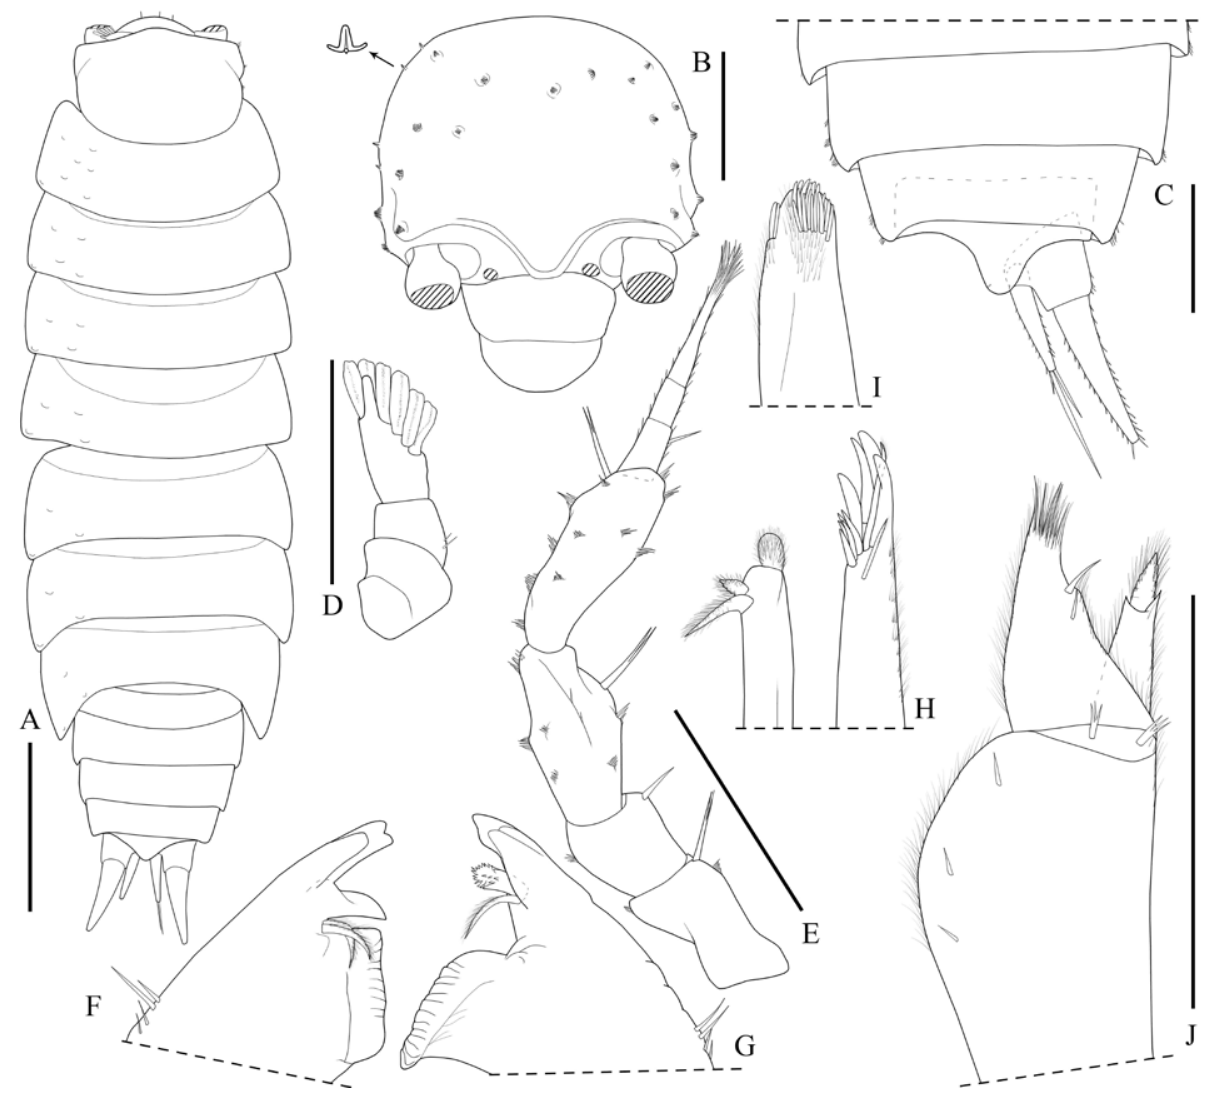
Figure 14. Pectenoniscus santanensis n. sp. Female paratype: A , habitus, dorsal view; B , cephalon, frontal view; C , pleonites 3–5, pleotelson and uropod, dorsal view; D , antennula; E , antenna; F , left mandible; G , right mandible; H , maxillula; I , maxilla; J , maxilliped. Scale bars: A : 0,5 mm; D : 0,1 mm; B, C, E–J : 0.2